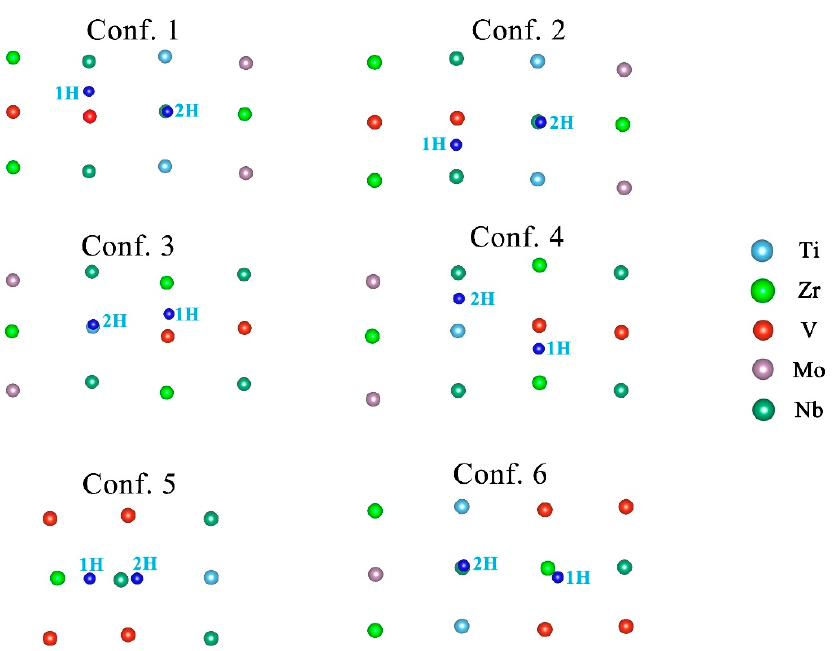
Figure 7. Top view of the TiZrVMoNb hydride (110) surface. The top (T), long bridge (LB), hollow (H) and short bridge (SB) sites are indicated.